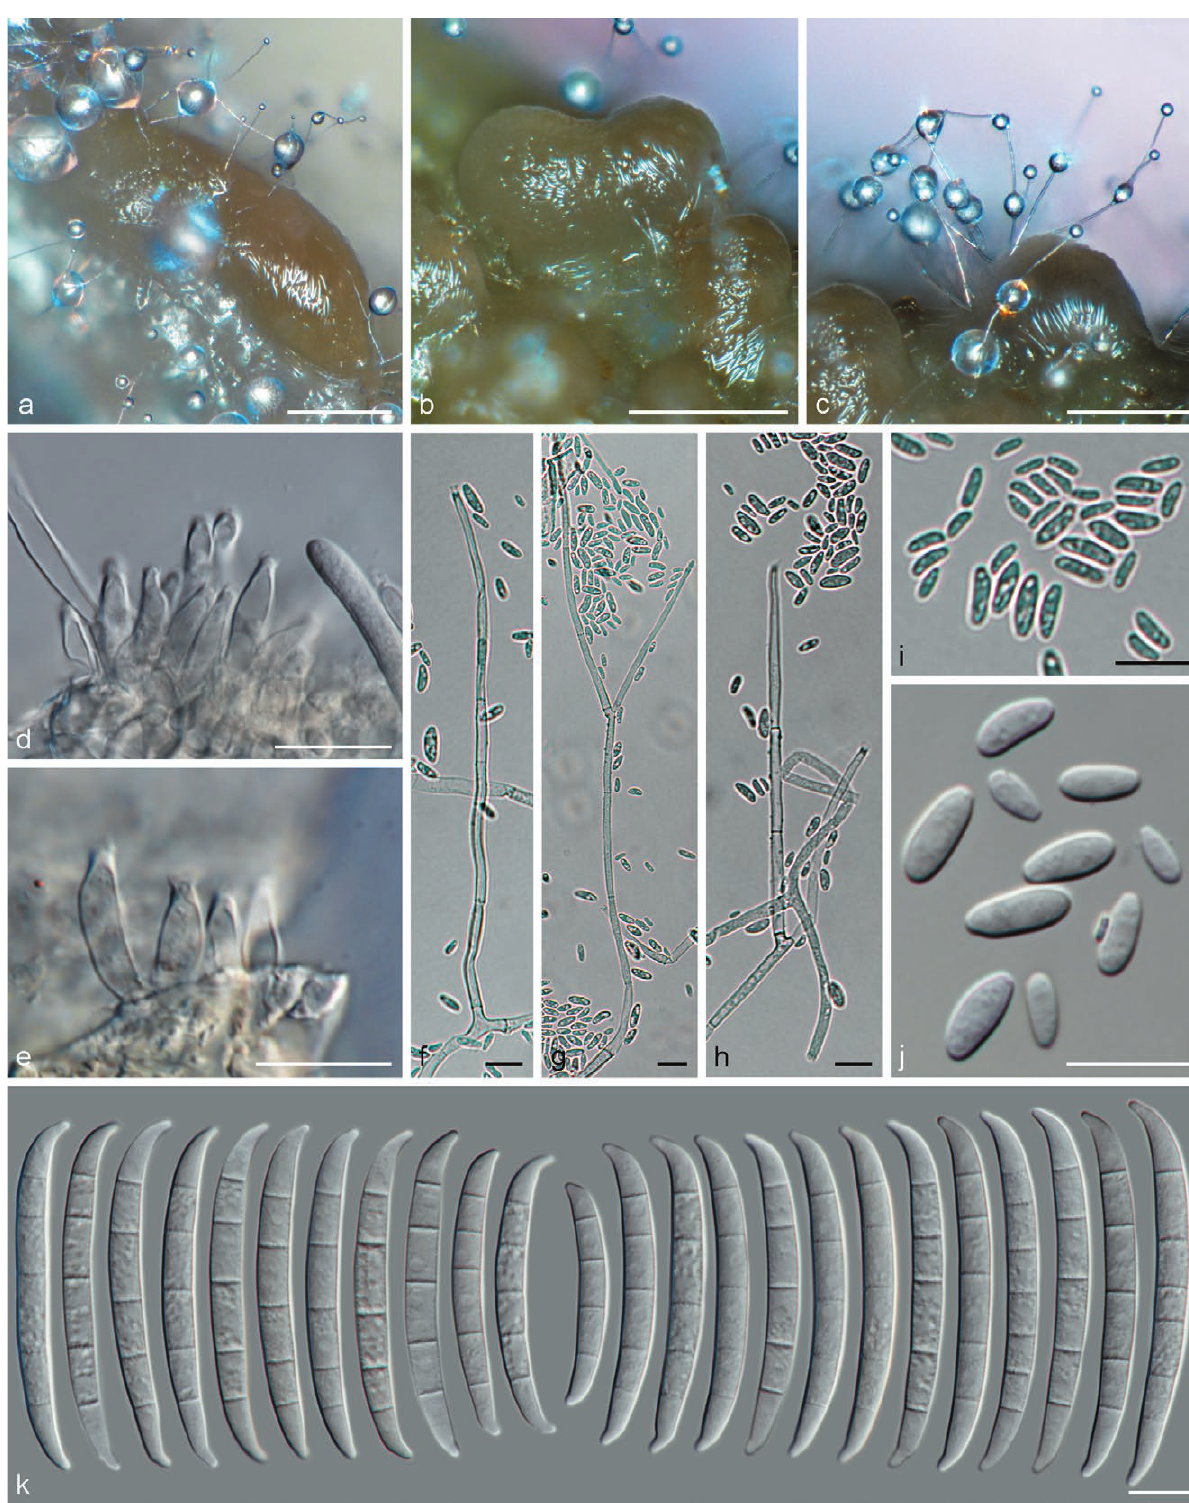
Figure 6. Neocosmospora gamtoosensis (ex-type culture CBS 146502). (a toc) sporodochia formed on the surface of carnation leaves; (d and e) sporodochial conidiophores and phialides; (f to h) aerial conidiophores; (I and j) aerial conidia; (k) sporodochial conidia. Scale bars: a and b = 100 μm; c to k = 10